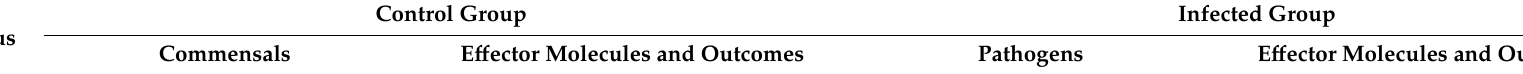
Table 1. Comparison between commensal and pathogenic gut-microbiota mediated immune modulation in AIV, IBDV, MDV, and NDV infected chickens.